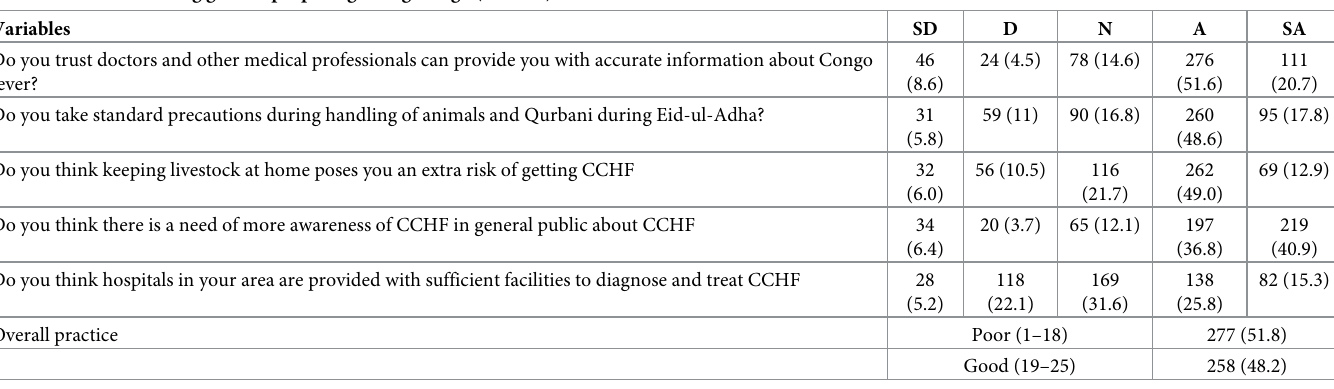
Participants aged ranging from 22–25 years had low odds ratio of good practice than those were 26 years old or more (OR = 0.56; 95% CI = 0.37–0.84, p = 0.005). Similar to knowledge and attitudes, practices were also influenced by the education and income status. Participants with matriculation degree and lower income had lower odds of good practice toward CCHF (OR = 0.38; 95% CI = 0.15–0.95, p = 0.040, and OR = 0.40; 95% CI = 0.25–0.64, p < 0.001, respectively) (Table 8).